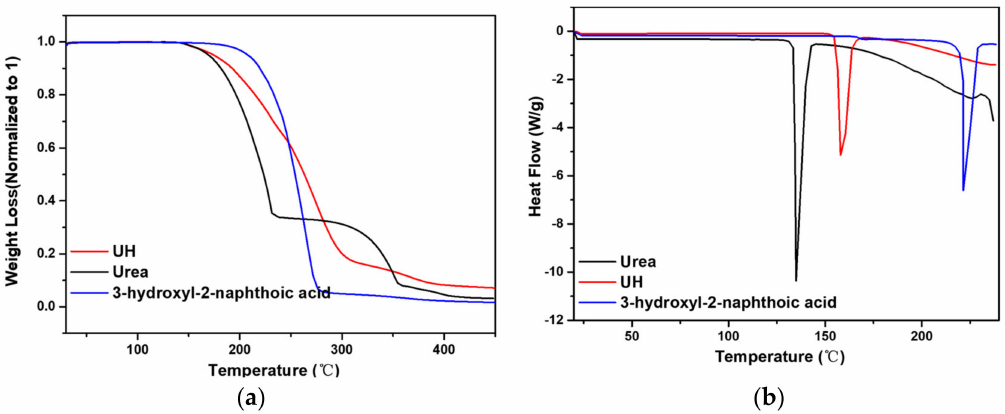
Figure 7. ( a ) TGA curves of urea, catechin and UC. ( b ) DSC curves of urea, catechin and